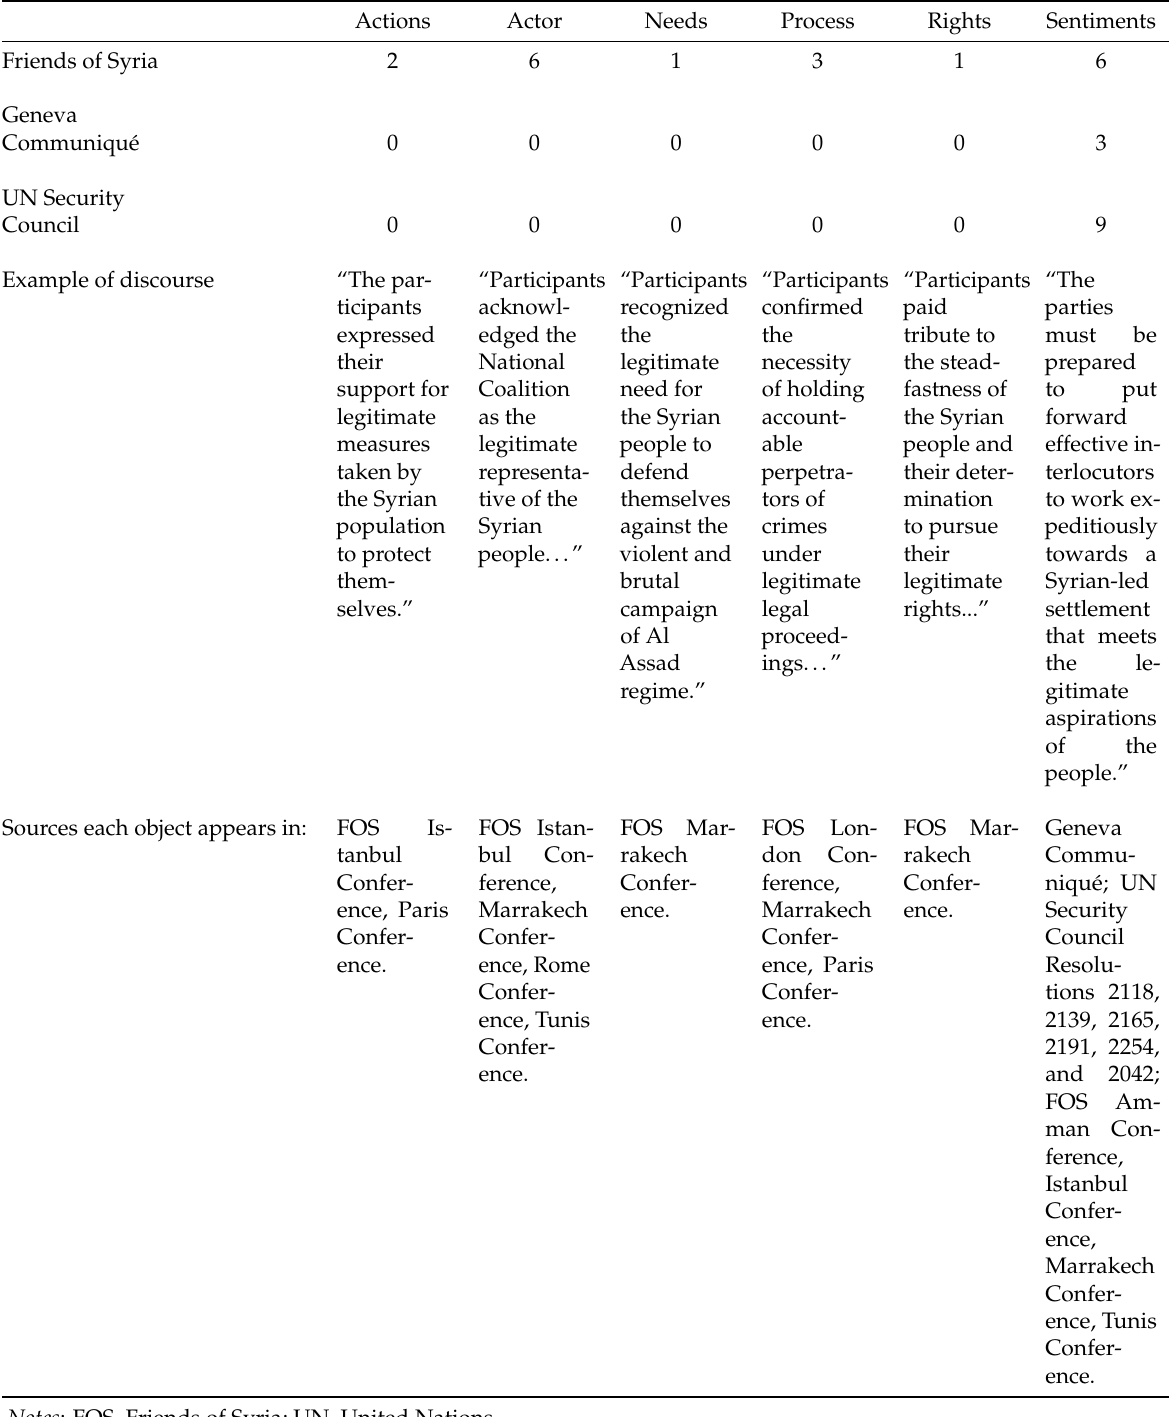
Table 1: Objects framed in collective international statements and resolutions regarding the Syrian Civil